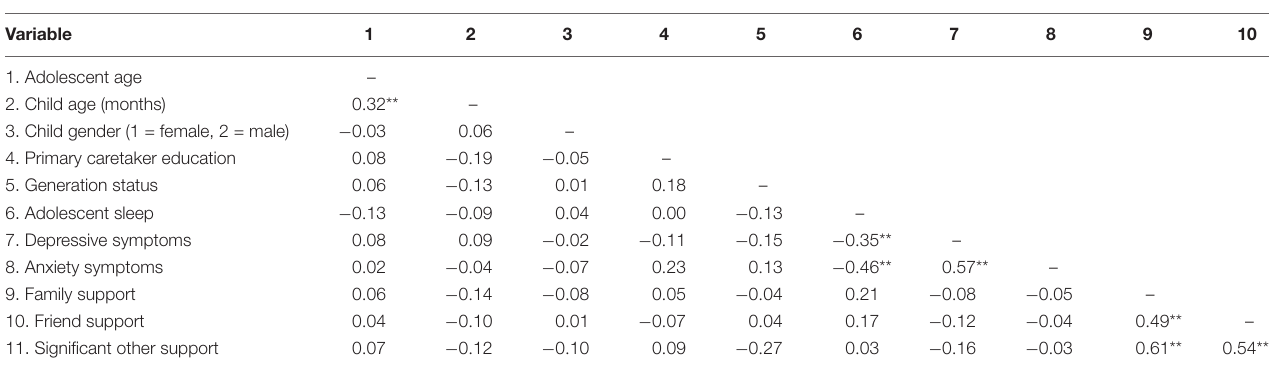
TABLE 2 | Correlations between demographic variables, sleep, social support, and mental health variables.